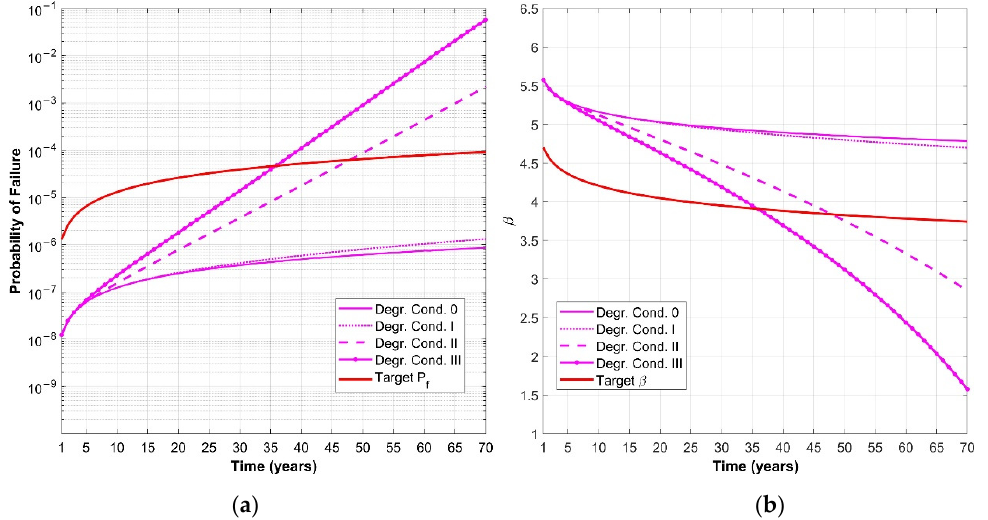
Figure 7. Time-dependent probability of failure ( a ) and reliability index β ( b ) for residential buildings—reinforcing steel class 2 and concrete class 3 for different steel degradation conditions.